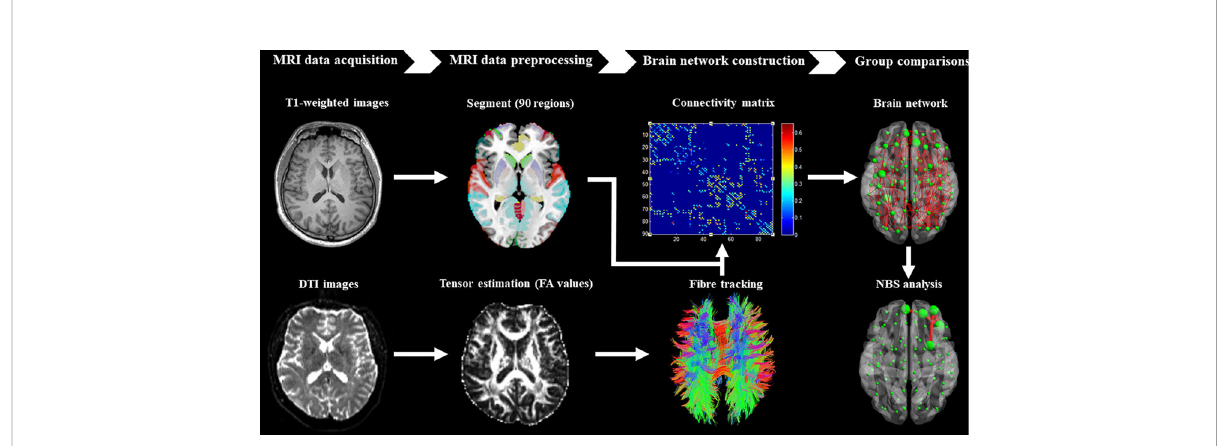
FIGURE 1 Brief fl ow chart showing MRI data acquisition, preprocessing, construction of structural brain network, and network-based statistical analysis between